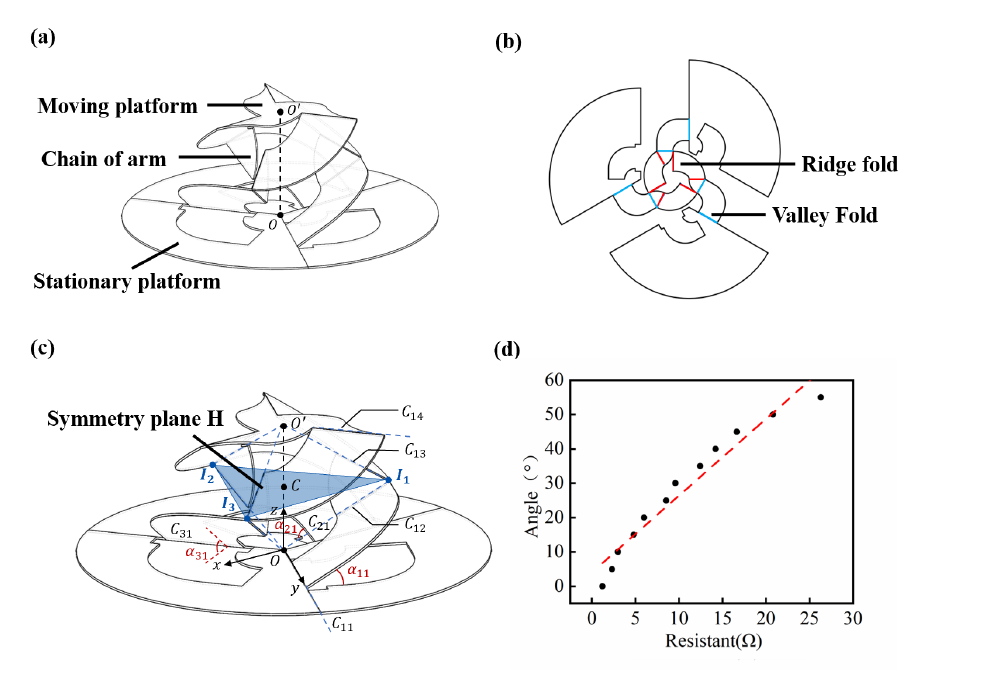
Figure 4. Sensor modeling and kinematics. ( a ) Schematic diagram of the three-dimensional mecha- nism of the miniature soft sensor. ( b ) Crease pattern of the miniature soft sensor, in which the blue line represents the folding method of folding forward to form a valley shape, and the red line represents the folding method of folding backward to form a mountain shape. ( c ) Schematic diagram of the mechanism with labels. ( d ) The relationship between the crease rotation angle and the resistance of the sensing